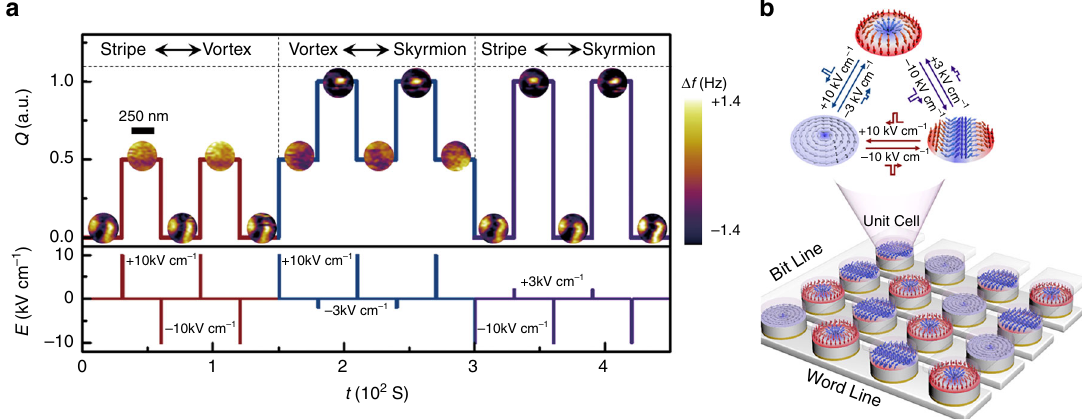
Fig. 3 Switching of individual skyrmions induced by pulse electric fi eld. a Switching of topological number Q of various magnetic domains ( Q = 1.0, 0.5, and 0 corresponds to skyrmion, vortex, and stripe, respectively) by applying a pulse electric fi eld with a pulse width of 1 ms. The insets contain the corresponding MFM images for the switching. The values of E for the generation of the skyrmion, vortex, and stripe are ±3, + 10, and − 10 kV cm − 1 , respectively. The MFM contrast represents the MFM tip resonant frequency shift ( Δ f ). The scale bar represents 250 nm. b Schematic of the envisioned cross-bar random access memory device based on the FM/FE multiferroic heterostructure nano-dots with the stripe, skyrmion and vortex as storage